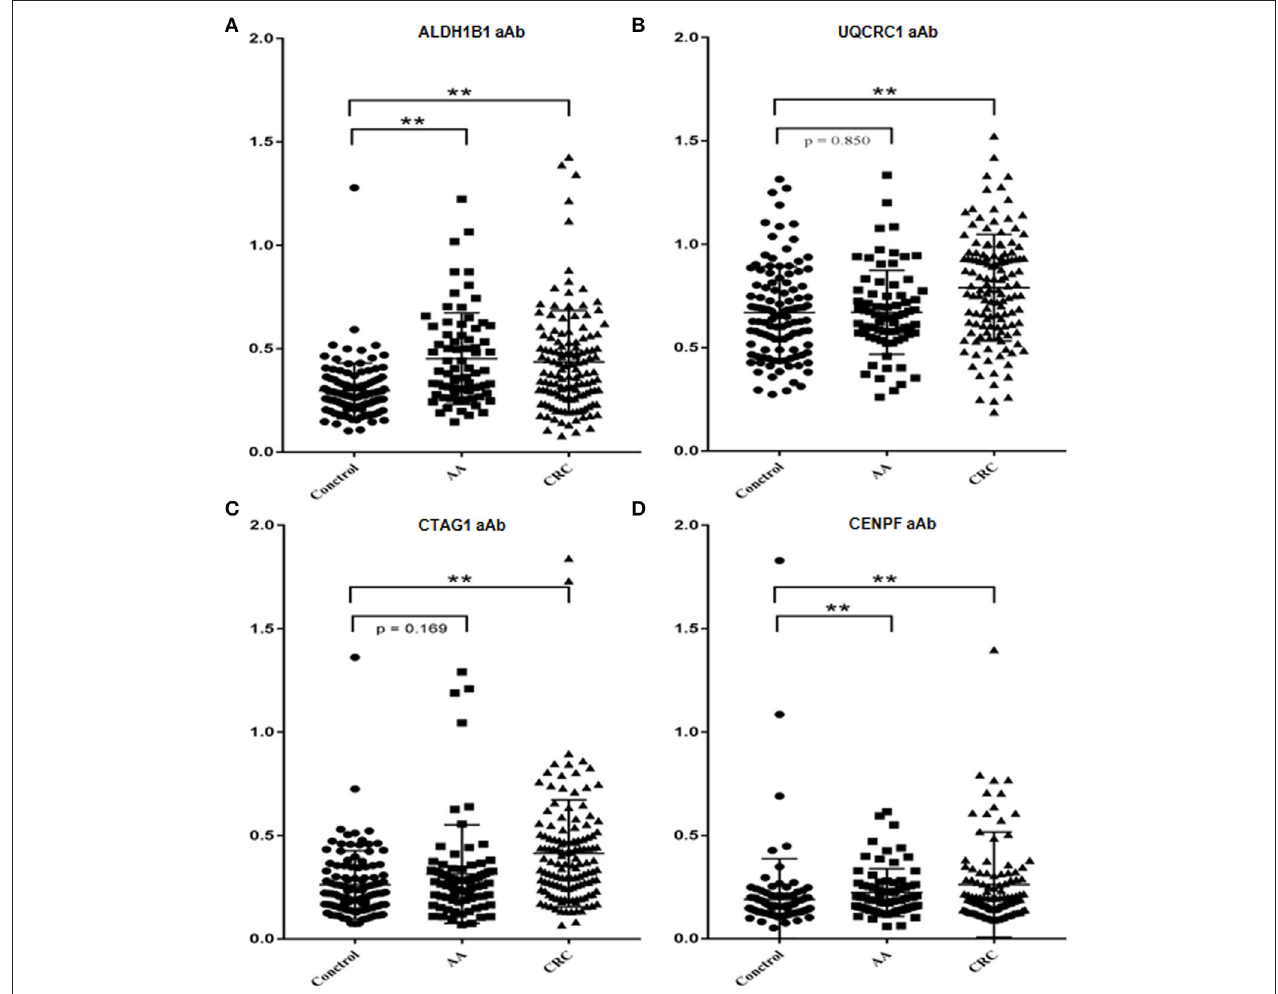
FIGURE 2 | Comparison of the levels of autoantibodies against selected TAAs examined by ELISAs. Scatter diagram of the OD values of ALDH1B1 (A) , UQCRC1 (B) , CTAG1 (C) , and CENPF (D) . ** p <